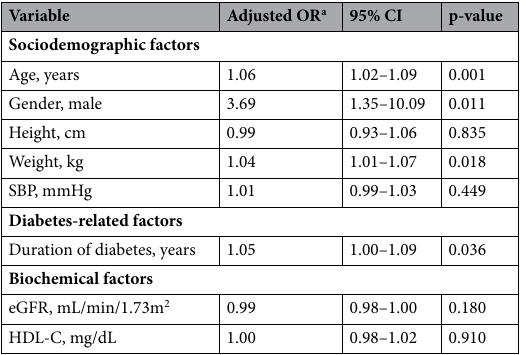
Table 2. Risk factors of future DPN in multivariable logistic regression. OR odds ratio, CI confidence interval, SBP systolic blood pressure, eGFR estimated glomerular filtration rate, HDL-C high-density lipoprotein cholesterol. a Multivariable logistic regression was adjusted for all variables in Table 2.